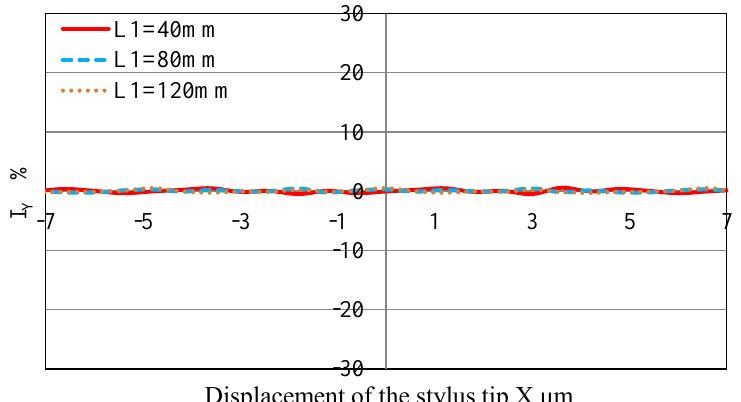
Figure 7. Simulation results for I Y for distances L 1 = 40, 80, and 120 mm ( X displacement of the stylus tip = ±7 µm).